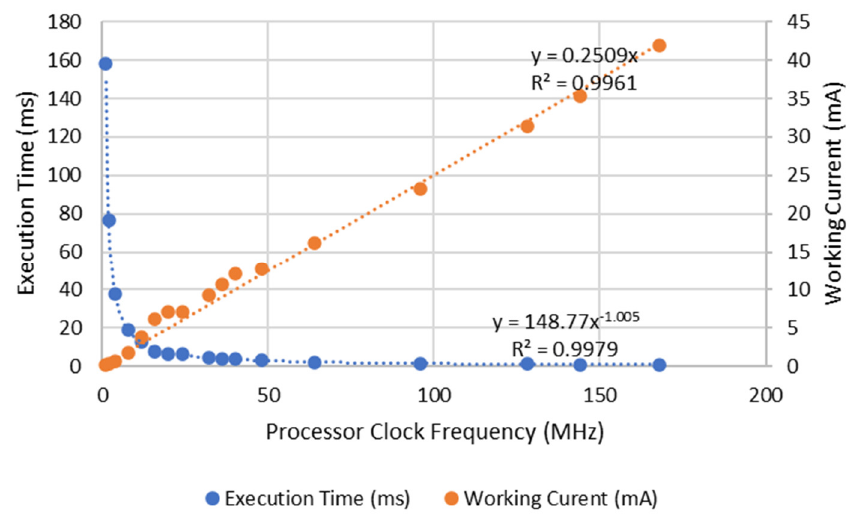
Figure 5. The relation between the execution time, the working current of the microcontroller itself, and the processor clock frequency.